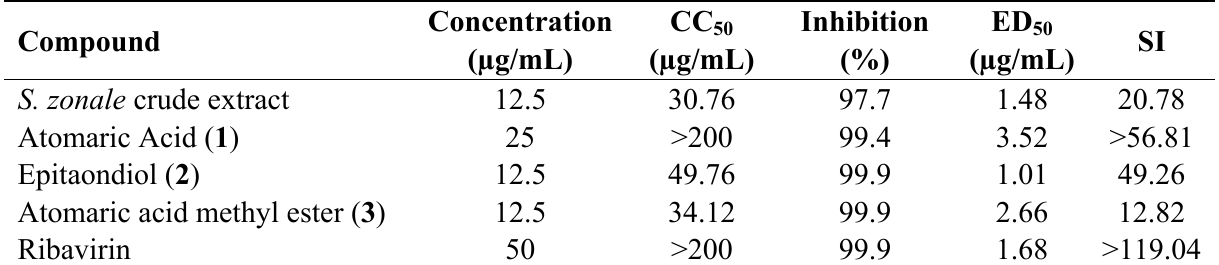
Table 1. Correlation between cytotoxicity and antiviral